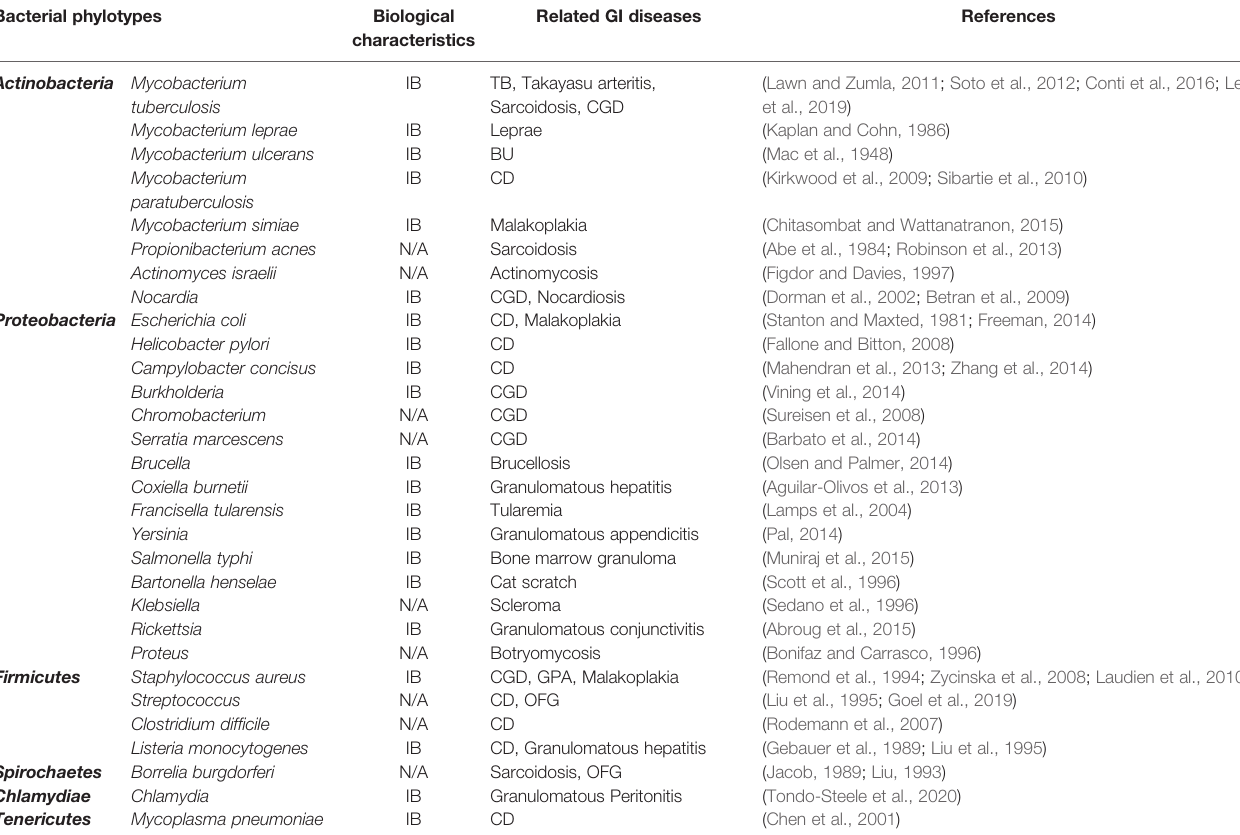
TABLE 1 | Overview of the bacterial phylotypes involved in GI diseases and their biological